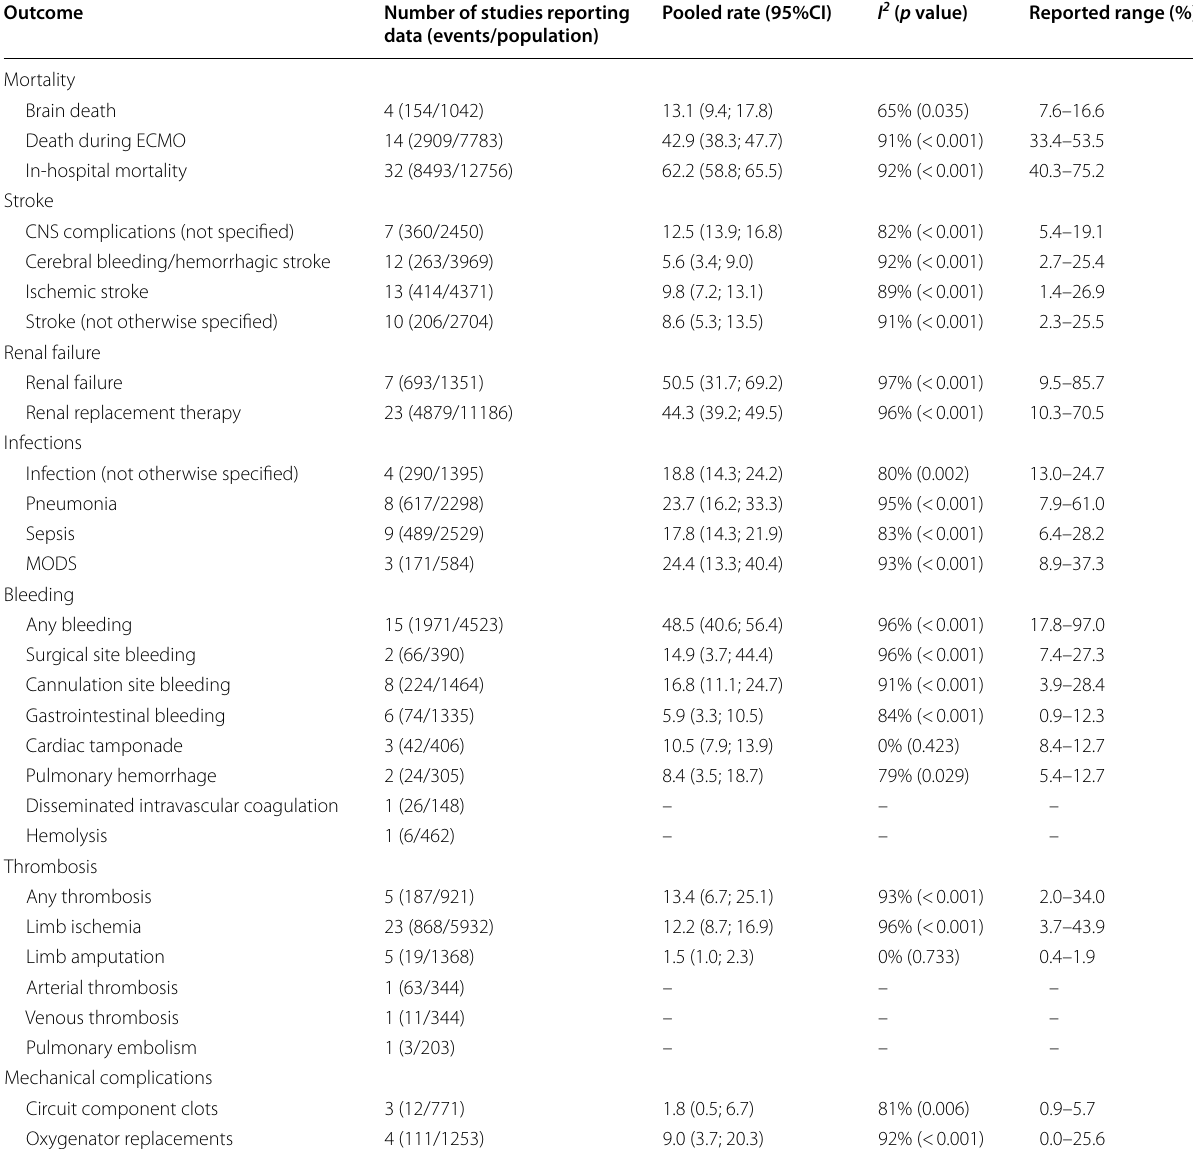
Table 2 Reporting of ECMO-related outcomes and complication rate